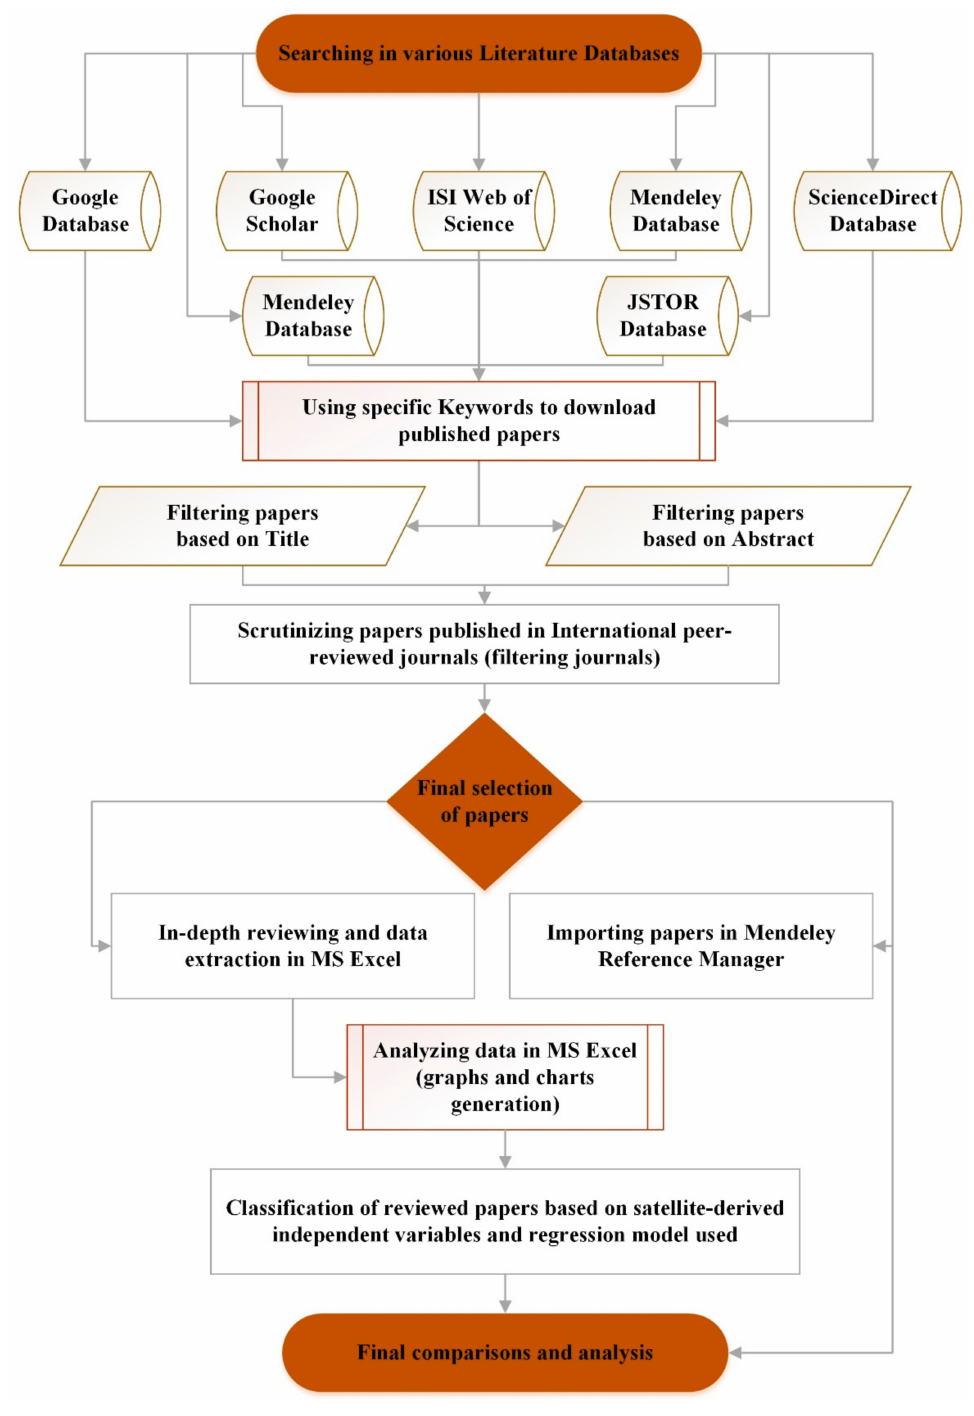
Figure 1. Workflow of the literature